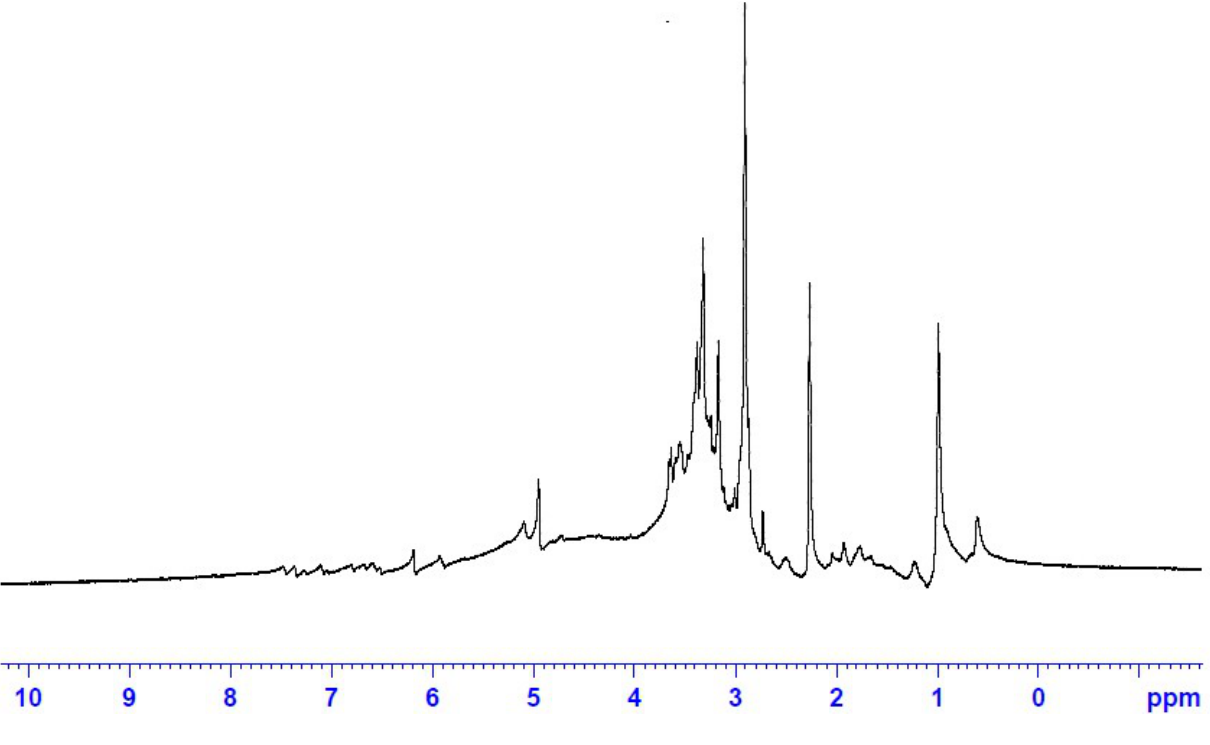
Figure 3. 1 HNMR spectrum of the ERF of M. arboreus in DMSO (400 MHz).